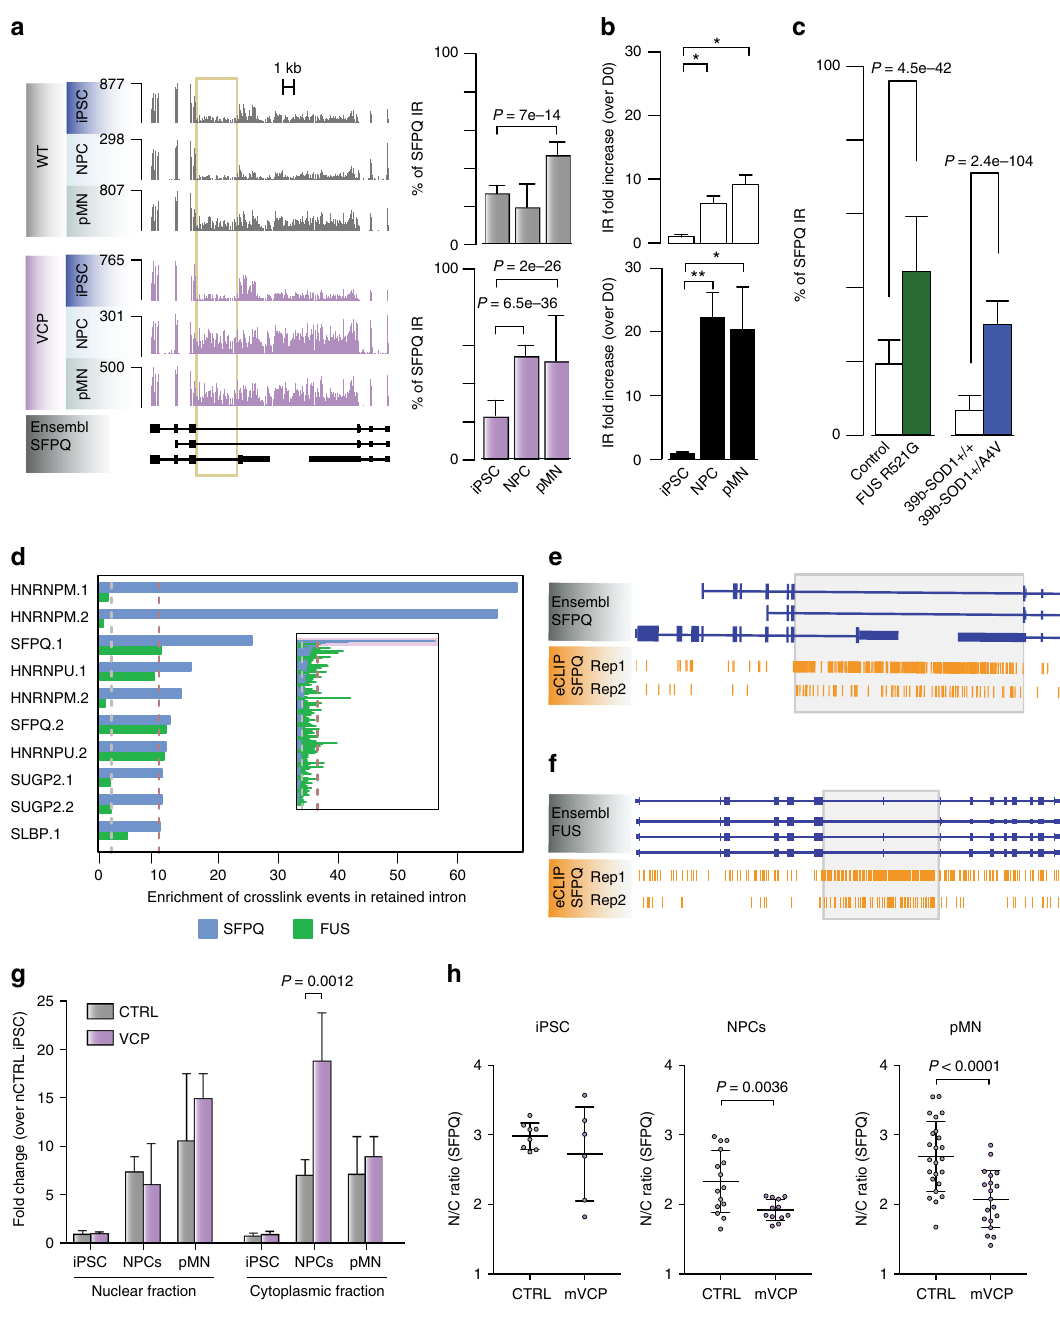
SLBP.1SUGP2.2SUGP2.1HNRNPU.2SFPQ.2HNRNPM.2HNRNPU.1SFPQ.1HNRNPM.2HNRNPM.1 Fig. 5 Aberrant SFPQ intron retention in diverse genetic forms of ALS and its interplay with the SFPQ protein. a Left, genome browser views of RNA-seq pro fi les for the intron-retaining gene SFPQ in control and VCP mu samples at iPSC, NPC and pMN stages. 9 kb intron 9/9 of interest is indicated with yellow box. Right, bar graphs quantifying percentage IR across the entire time course in control and VCP mu samples (mean ± s.d.; Fisher count test). b Bar plots displaying SFPQ IR levels measured by qPCR; white bars = controls, black bars = VCP mu . IR levels at each timepoint were compared with that of the iPSC stage of the same group. N = 3 control lines and N = 4 VCP lines (mean + s.d. * p < 0.05, ** p < 0.01, one-way ANOVA with Dunnet correction for multiple comparisons). c Bar plots showing the percentage SFPQ IR for FUS mu or SOD1 mu MNs in control compared with (mean ± s.d.; Fisher count test). d Bar plots depicting the level of enrichment in RBP-binding to the retained intron compared with the non-retained introns within the same gene; blue bars = SFPQ gene, green bars = FUS gene. e – f Genome browser view of SFPQ eCLIP crosslinking events along SFPQ and FUS transcript annotations. Grey boxes highlight the location of retained introns. g Bar plots showing the level of nuclear and cytoplasmic localisation of IR transcripts measured by qPCR. IR levels in each fraction were compared with that of the nuclear fraction of control iPSCs. N = 3 control lines and N = 4 VCP lines, mean + s.d. P -value from two- way ANOVA with Tukey correction for multiple comparisons. h Subcellular localisation of SPFQ determined by immunocytochemistry in iPSCs, NPCs and pMNs. The ratio of the average intensity of the SFPQ staining in the nucleus (N) vs cytoplasm (C) was automatically determined in both CTRL and VCP mu cells. Data shown is average N/C ratio (±s.d.) per fi eld of view from four control and four VCP mu lines. P -value from unpaired t -test with Welch ’ s correction. See also Supplementary Fig.